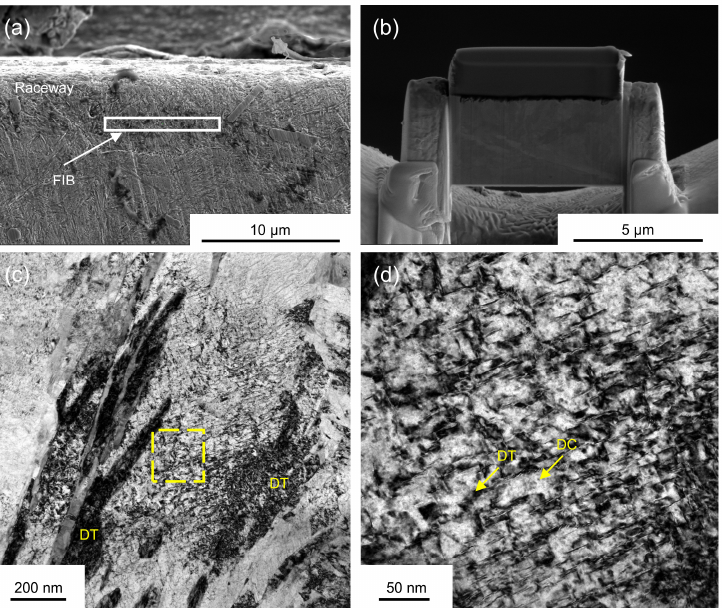
Figure 5. Microstructure observation of the region near the raceway in the RCF sample ( P 0 = 5 GPa, N = 2.12 × 10 8 cycles): ( a ) SEM micrograph of the region near the raceway and the position of the TEM specimen prepared using FIB; ( b ) image of the FIB lamella; ( c ) TEM micrograph; ( d ) TEM micrograph of the highlighted area in ( c ).